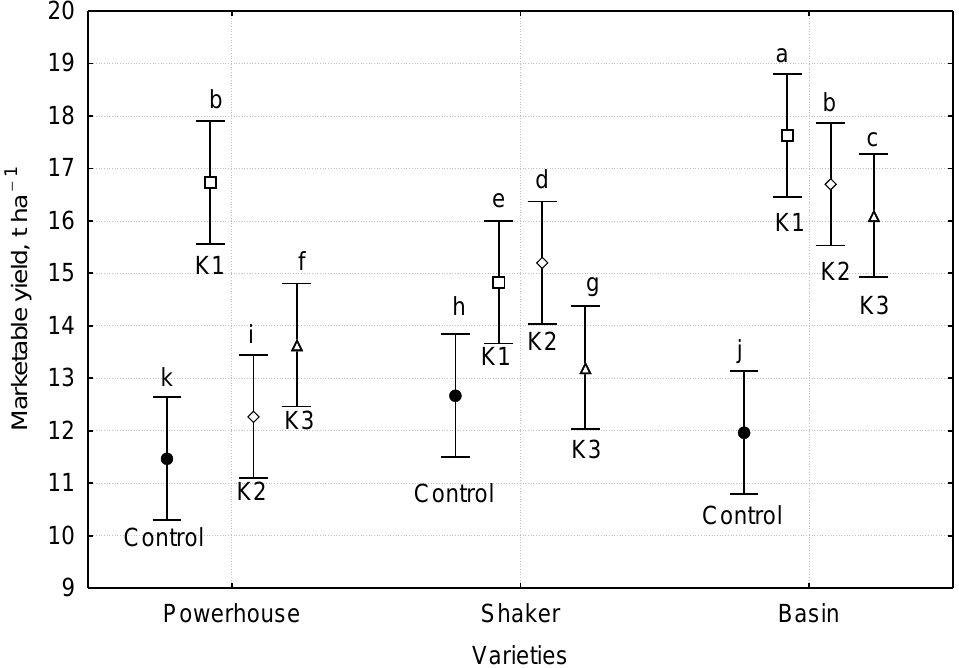
Figure 3. Mean values for marketable yield with 95% confidence intervals relative the number of light exposures and respective corn cultivars (mean of two years). Means with the same letter are not significantly different from each other ( p < 0.05—ANOVA followed by Tukey test). Error lines represent ± standard deviation of the mean.